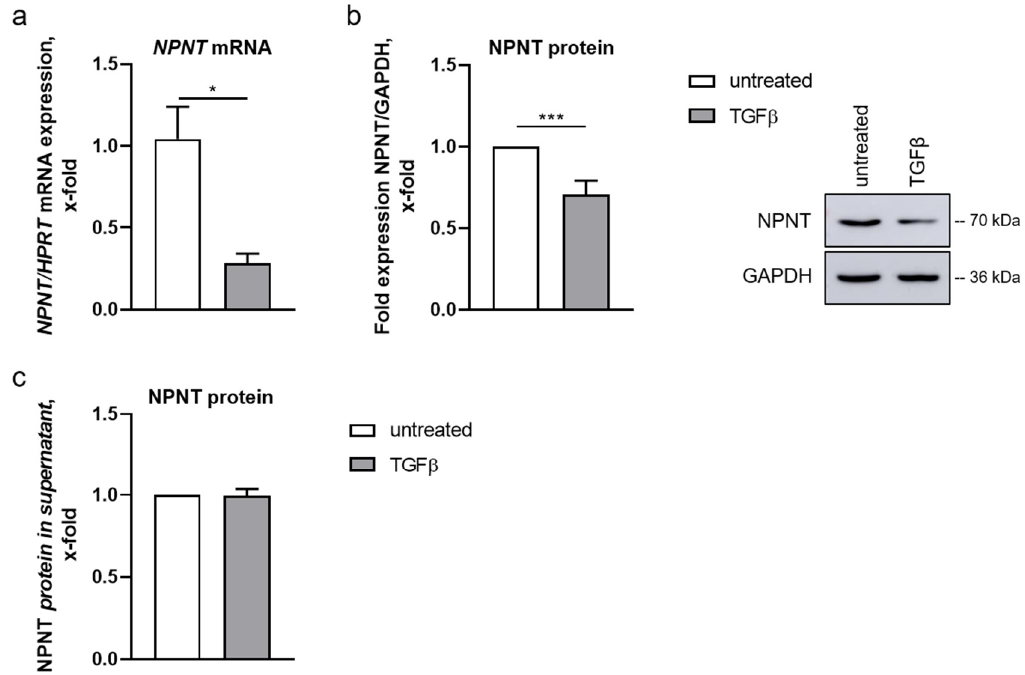
Figure 2. NPNT expression and localization in human podocytes. ( a , b ): NPNT mRNA ( a ) and protein ( b ) expression in cultured human podocytes, untreated and after TGF- β treatment. NPNT expression was normalized to HPRT and GAPDH, respectively, and is given as change compared to untreated cells. A representative Western blot picture is shown. n = 3–17 independent experiments, * p < 0.05, *** p < 0.001. ( c ): Change in NPNT protein concentration measured in the cell culture supernatant of untreated cultured human podocytes and after stimulation with TGF- β . n = 5 independent